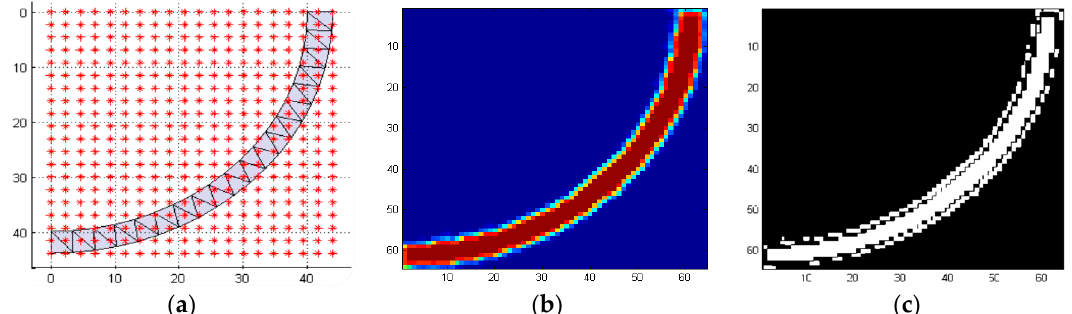
Figure 7. Process flow for CAD model into point cloud processes.